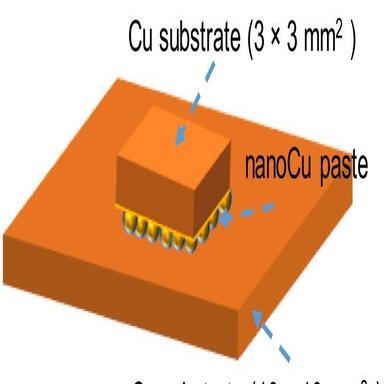
A schematic illustration of Cu/nanoCu/Cu joints.